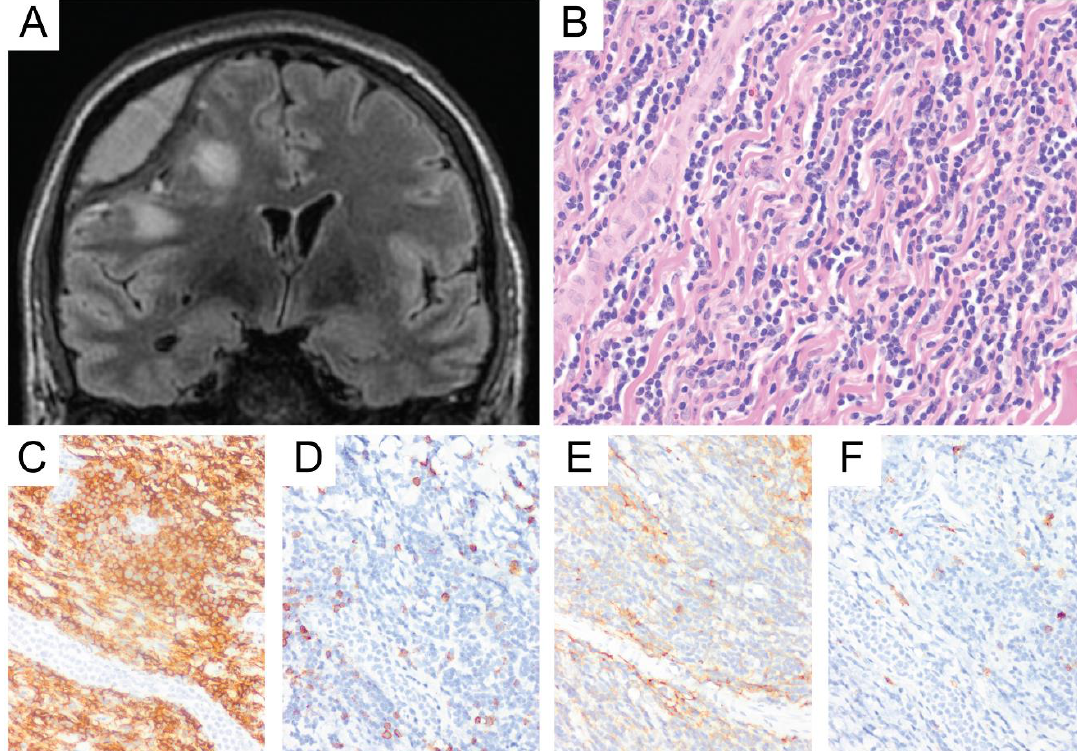
Figure 7. MALT lymphoma of the dura. This lymphoma typically presents as an enhancing dural-based mass (so-called “dural tail”), often mistaken for meningioma ( A , coronal section, magnetic resonance imaging FLAIR sequence). The tumor cells are small-to-medium-sized with irregular nuclei and abundant cytoplasm and are embedded within a background of fibrous dura ( B , original magnification ×400). The tumor cells are often positive for CD20 ( C ) and negative for CD5 ( D ), CD10 ( E ), and CD23 ( F ) ( B – F , original magnification ×200).